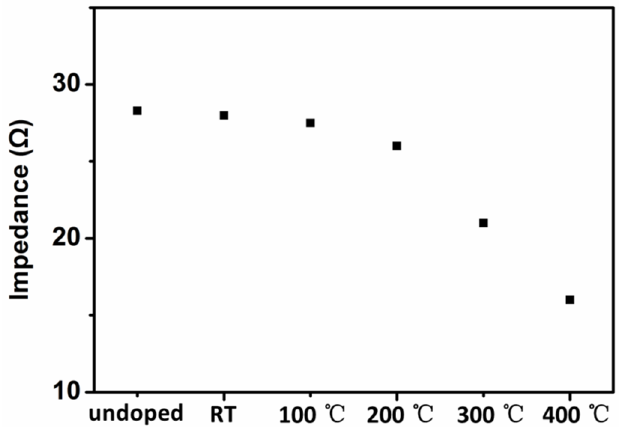
Figure 10. Impedance of samples deposited at different substrate temperatures.